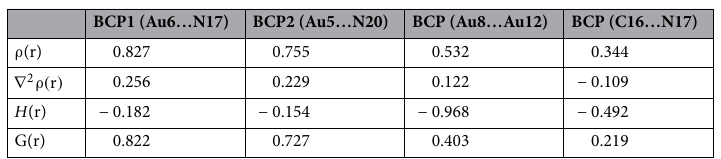
Table 3. Calculated BCPs parameters with DFT ‒ D3 / TZVP for adenine/Au13